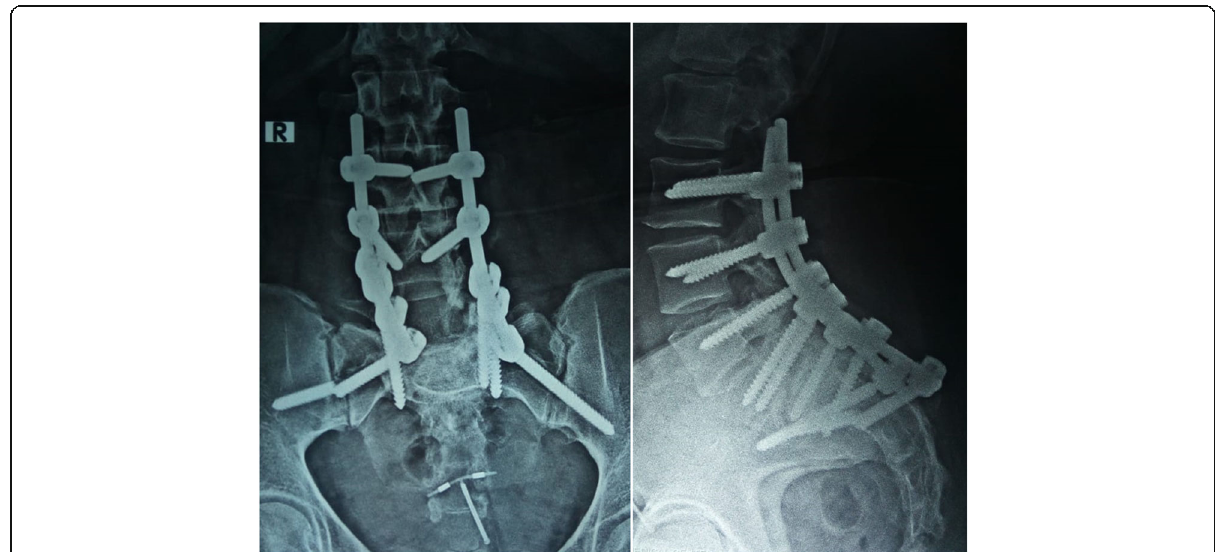
Fig. 5 Six months postoperative AP and lateral plain X-ray images of the lumbosacral spine region showing Rt pelvic screw failure and break out in a patient operated for lumbopelvic fixation for correction of high-grade isthmic spondylolisthesis (note the vertically oriented superior sacral endplate with a resultant high-degree sacral